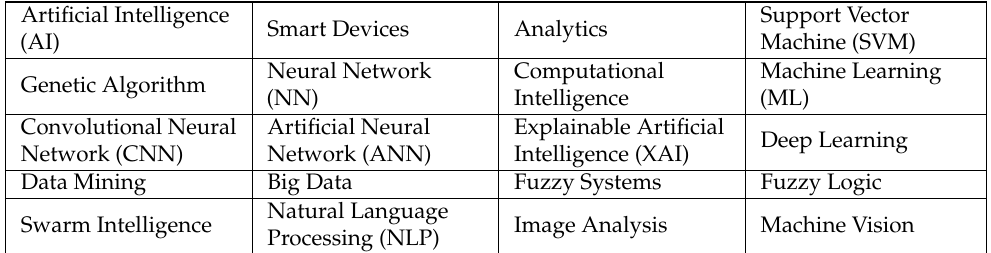
Table 2. Key Search Terms Interchangeable with (Explainable) Artificial Intelligence in the Literature Search